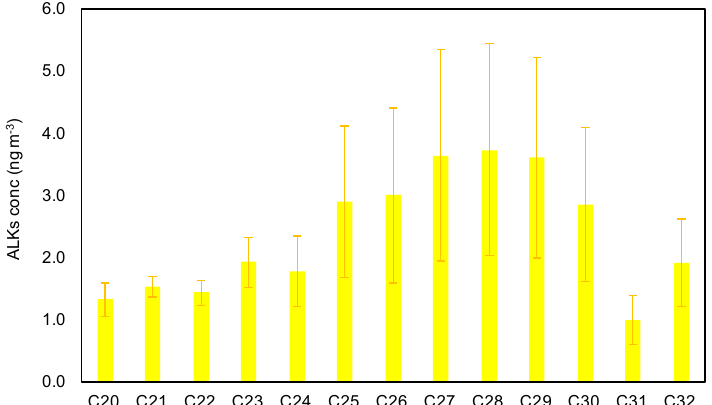
Figure 14. ALKs pattern in gas phase during AREX2011.